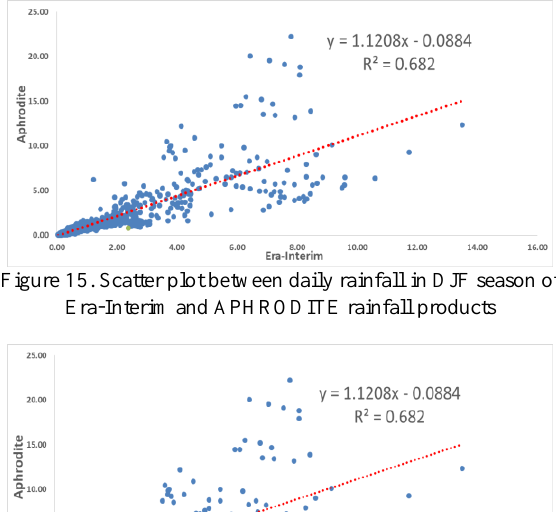
Figure 10. Suitability with IMD Figure 11. Suitability with